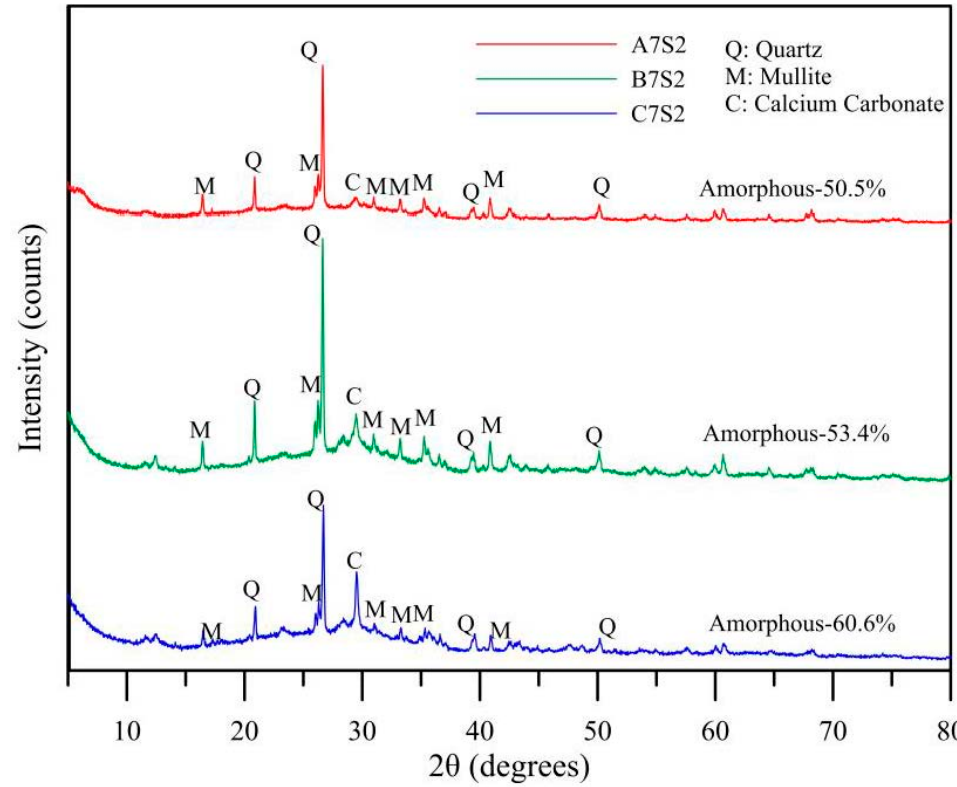
Figure 7. XRD analysis of different fly ash mixtures at alkali equivalent = 7% and 20% GGBFs re- placement.